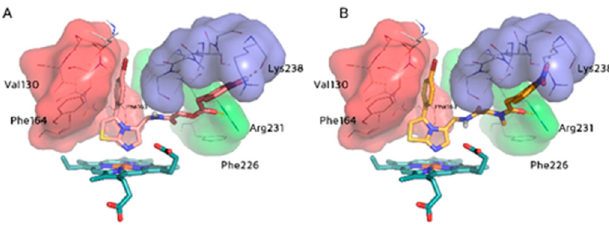
Figure 2. Docking poses of compounds 2 ( A ) and 3 ( B ). Structures are depicted as pink and orange sticks, respectively, while heme is depicted as cyan sticks. Red surface: pocket A; green surface: pocket B; blue surface: pocket C.